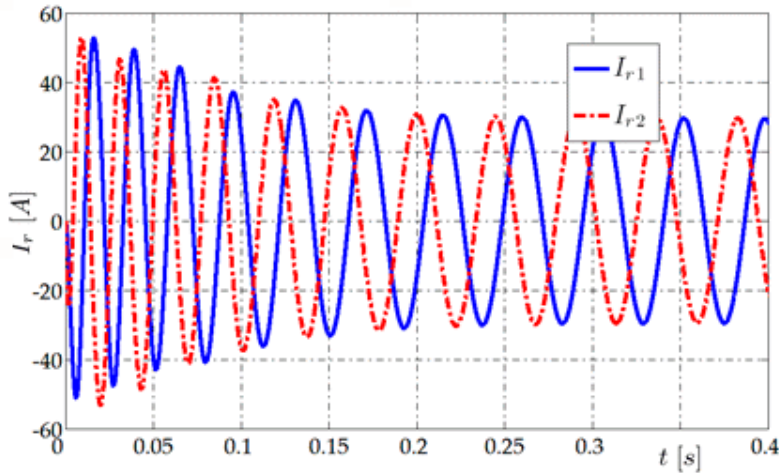
Figure 8. The phase currents in the rotor windings during the start-up motor for load torque 15 Nm.